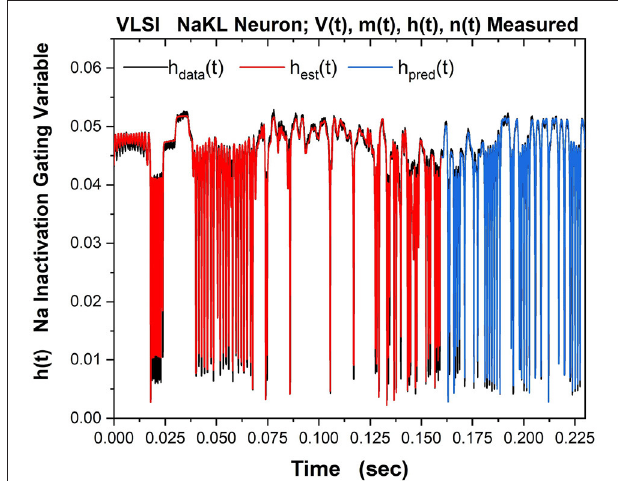
FIGURE 8 | This waveform for I injected ( t ) was used to drive the VLSI NaKL neuron after receipt from the fabrication facility.